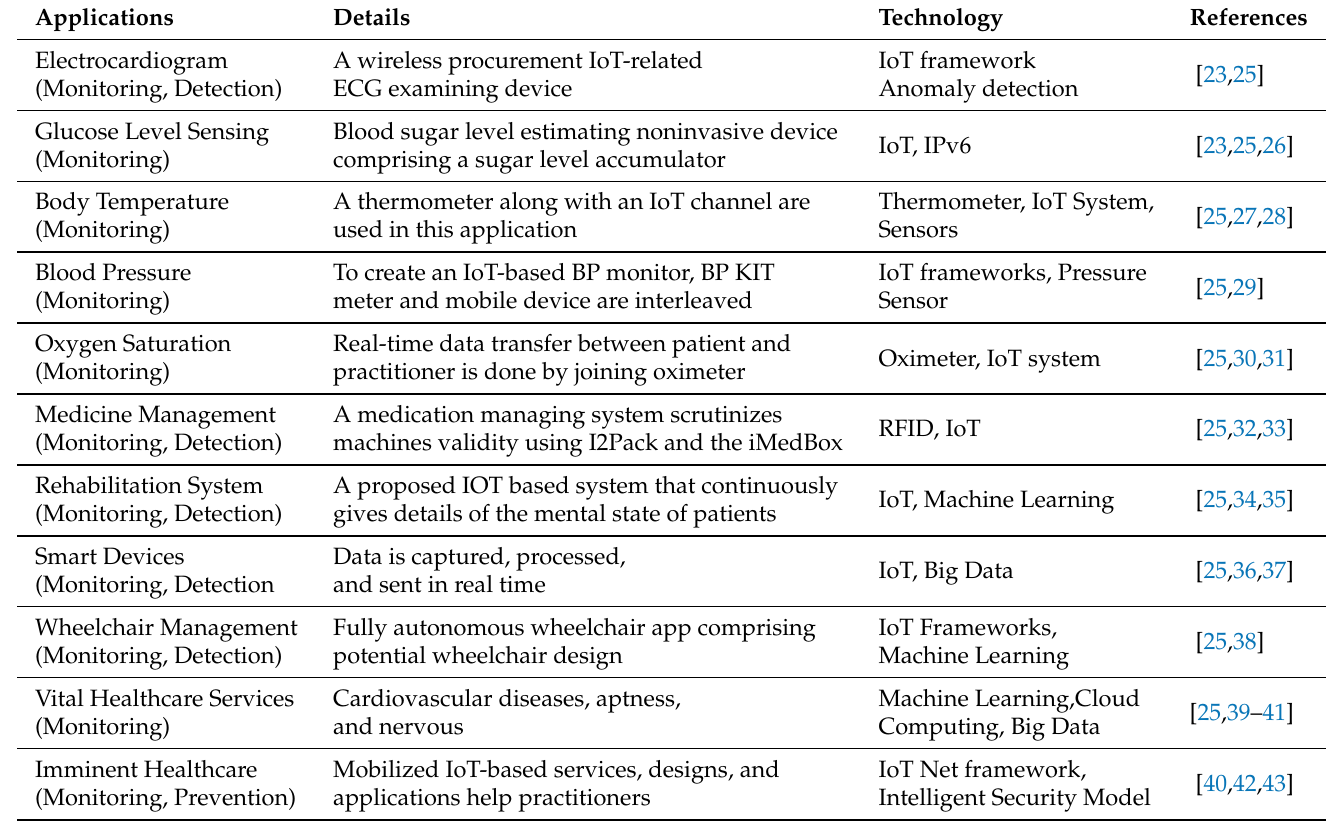
Table 1. IoT healthcare applications and precise use cases